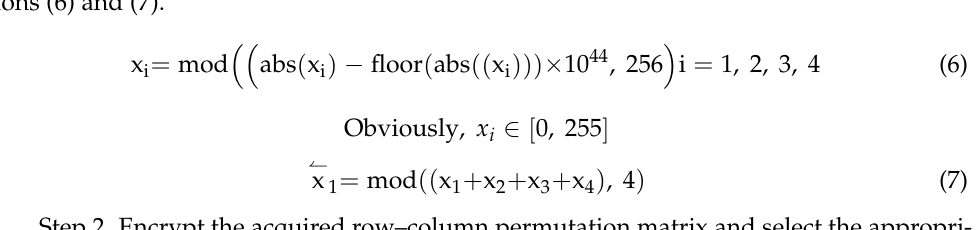
Step 2. Encrypt the acquired row–column permutation matrix and select the appropri- ate combination from Table 2 based on x 1 [ 0.3 ] .